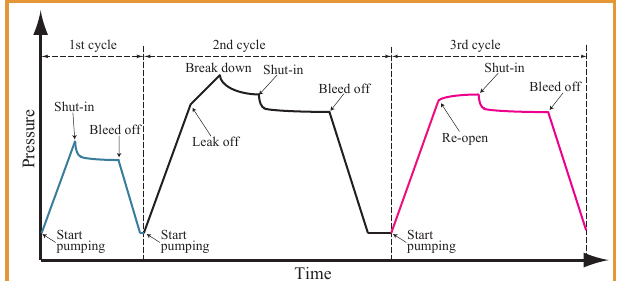
Figure 4. Suggested procedures for conducting XLOT to determine the magnitude of the minimum principal stress.